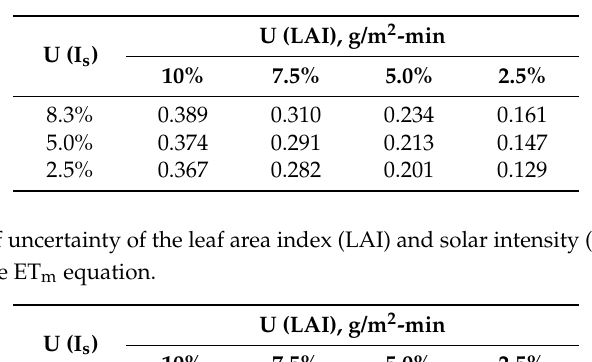
Table 6. The effect of uncertainty of the leaf area index (LAI) and solar intensity (I s ) in the uncertainty analysis for the Stanghellini ET s equation.